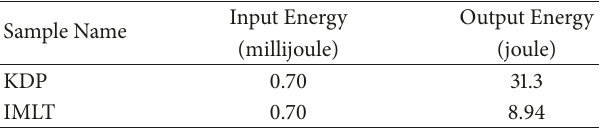
Table 3: Nonlinear observation of IMLT and its comparison with